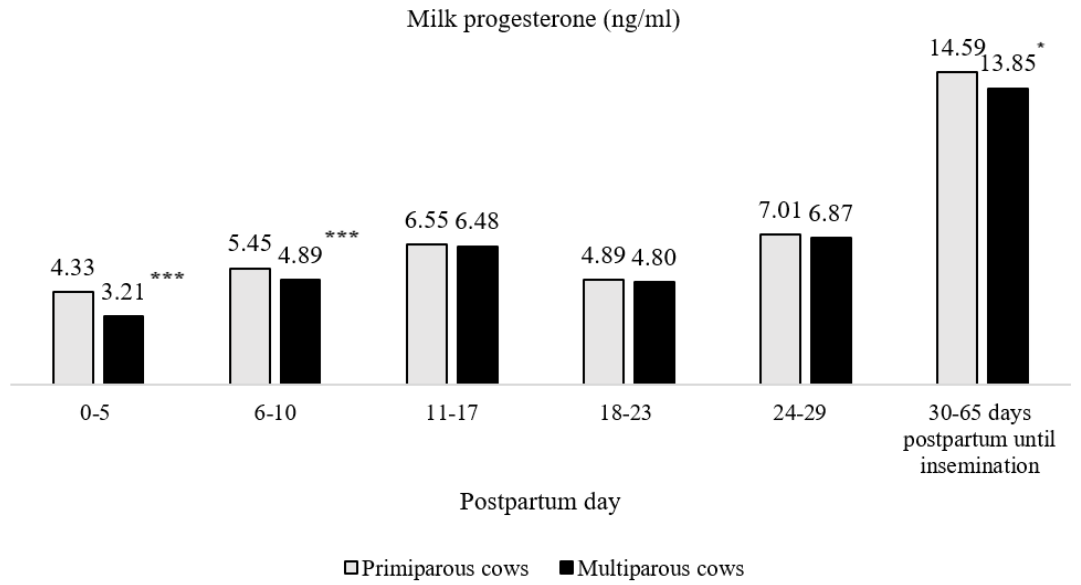
Figure 1. Changes in the concentration of milk progesterone during the postpartum period (* p < 0.05, *** p < 0.001—average values of progesterone in milk between primiparous and multiparous cows are statistically significantly different) .